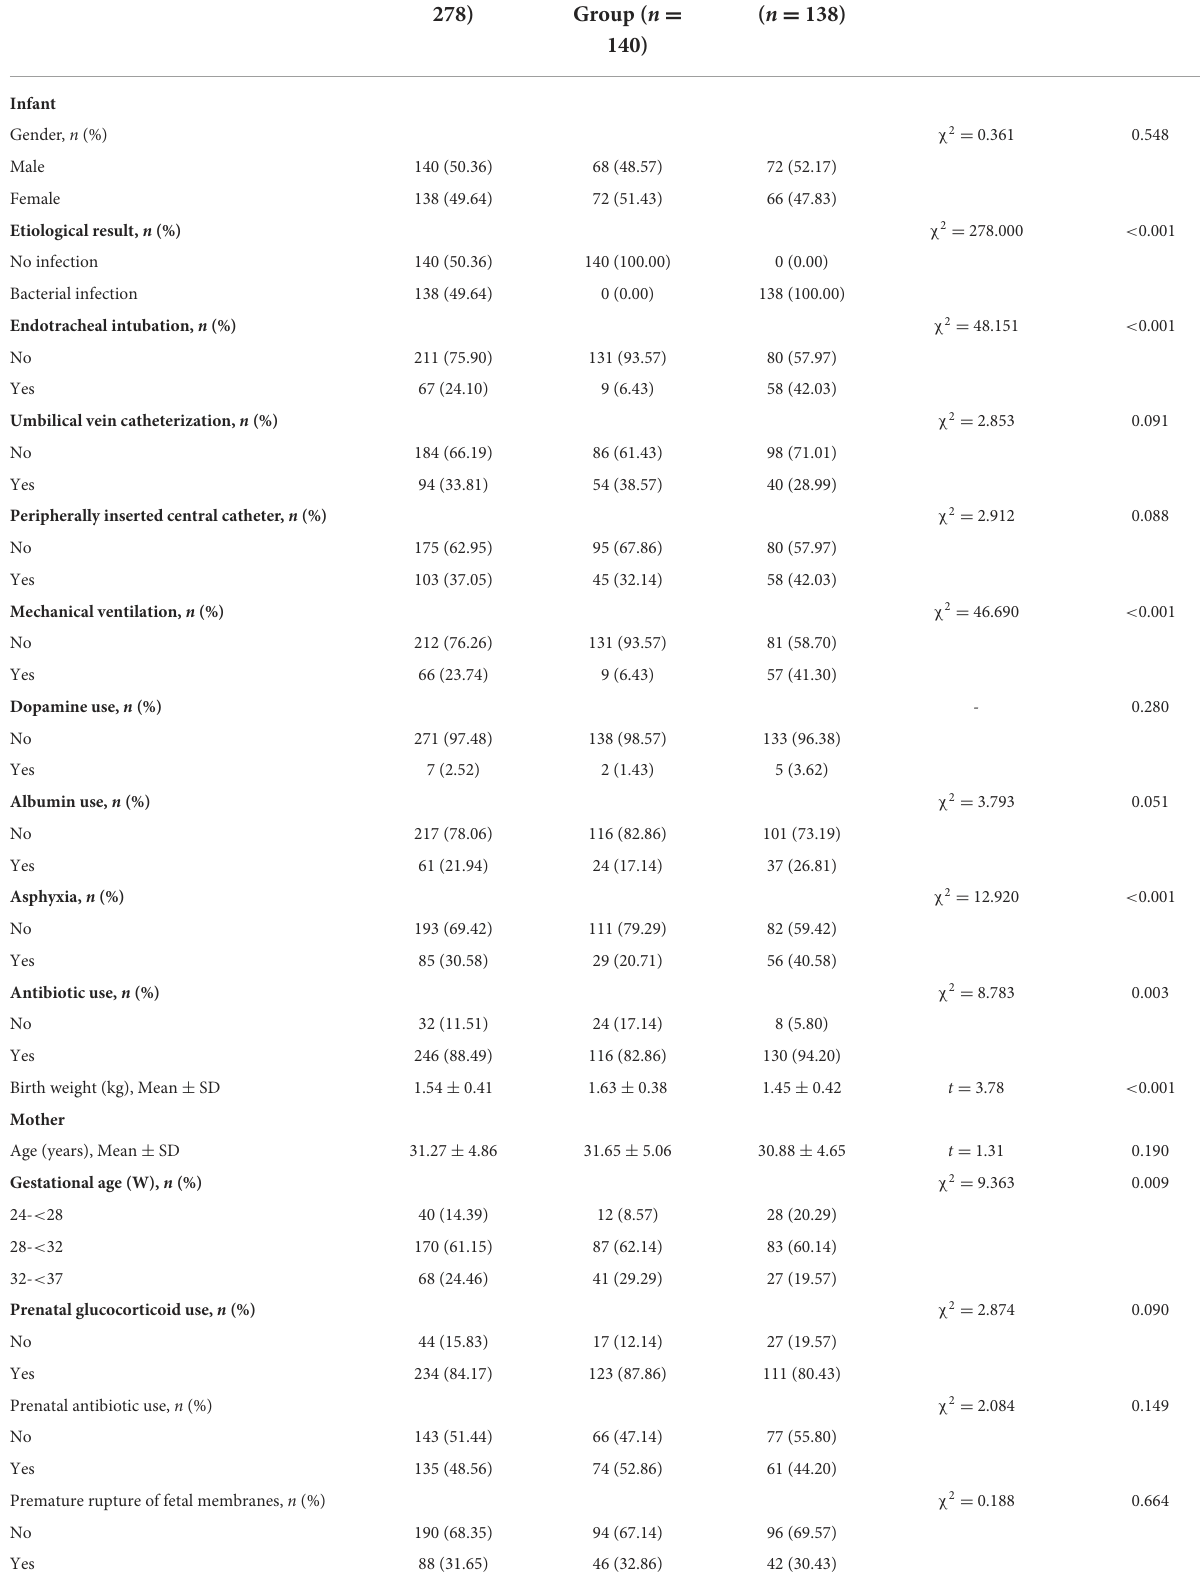
TABLE 2 Comparisons of characteristics between the control group and the case group in the training